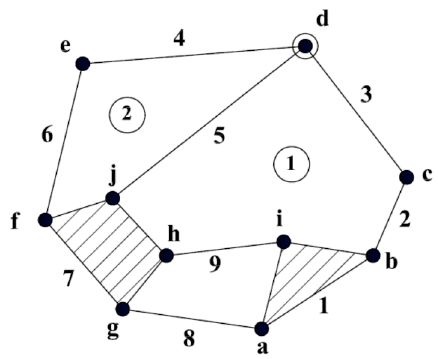
Figure 1. Topological structure of a 9-link planar kinematic chain with simple and multiple joints.